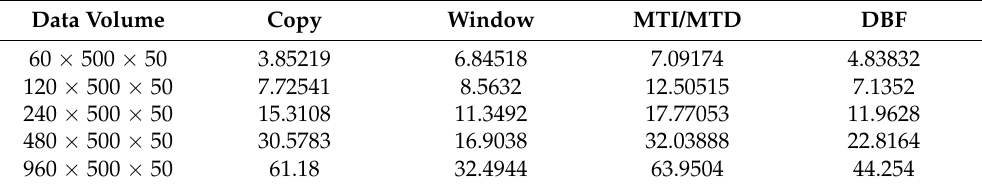
Table 3. Simulation time (ms).